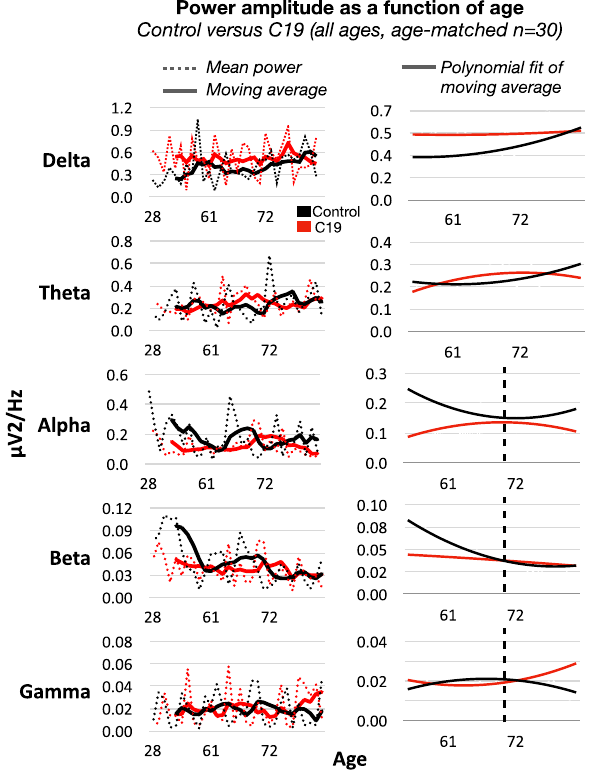
Figure 3. (Left panel) Power values (mean of 16 channels) were plotted as a function of age in control and C19 subjects, superimposed over 3-steps moving averages in each group, for delta, theta, alpha, beta and low gamma bands. Of note, X-axis values represent the average age for each pair of subjects based on the matching requirements of maximum 5 years difference (i.e. X-axis is non-linear). (Right panel) Moving averages shown in left panel were fitted with polynomial trend lines, which were convergent or intersecting around age 70 for alpha, beta and gamma (vertical lines). This formed the basis of group selection by age below and above 70